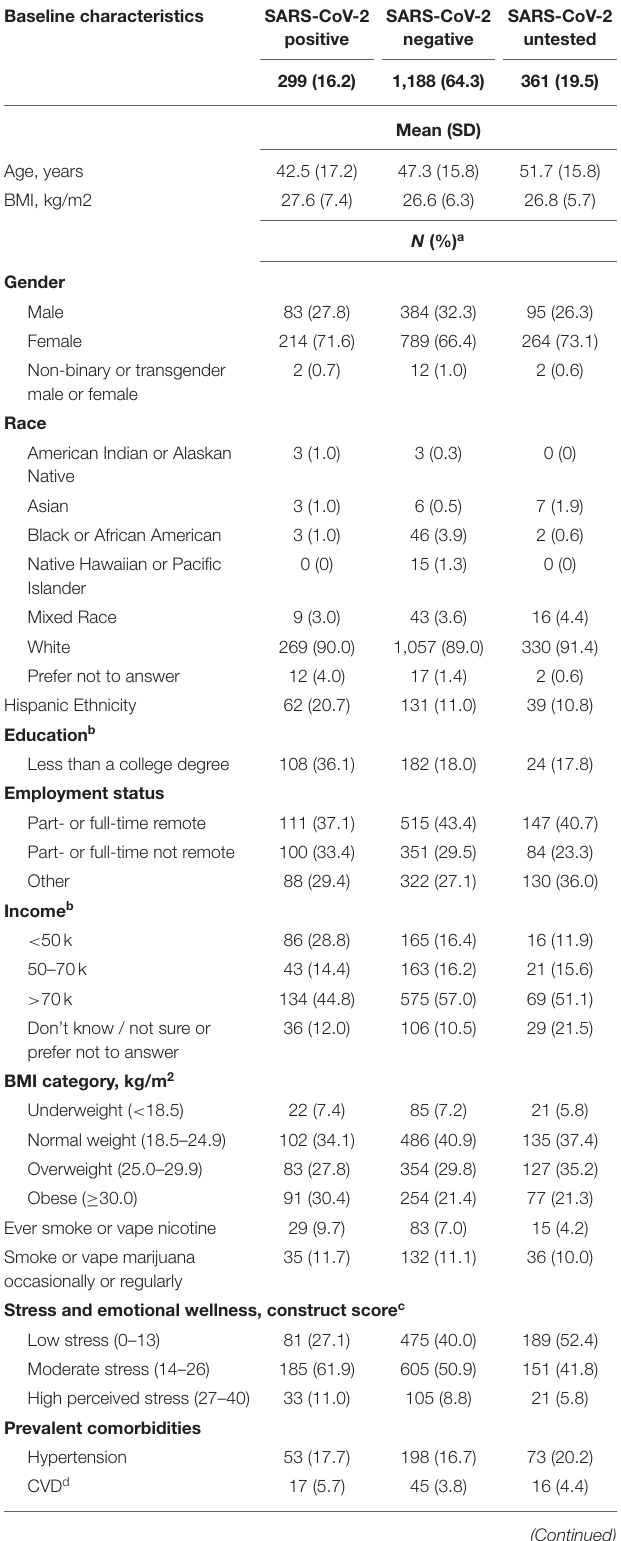
TABLE 1 | Characteristics of the Arizona CoVHORT study participants stratified by SARS-CoV-2 infection status, n = 1,848. Baseline